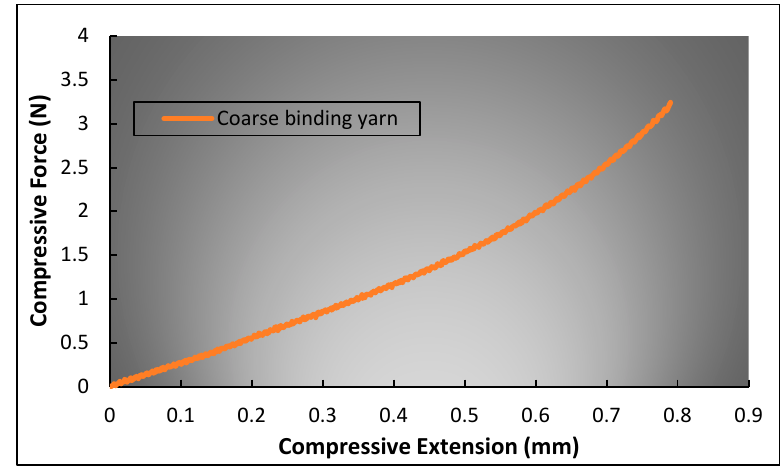
Figure 9. Compressive force–extension curve of coarse binding yarn.